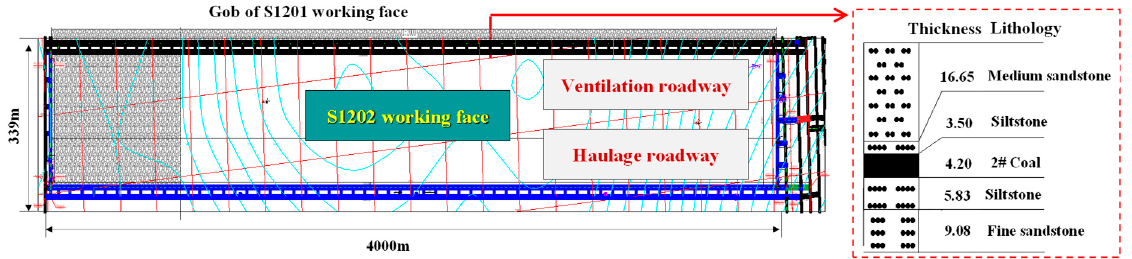
Figure 1. Working face parameters and rock stratum histogram.